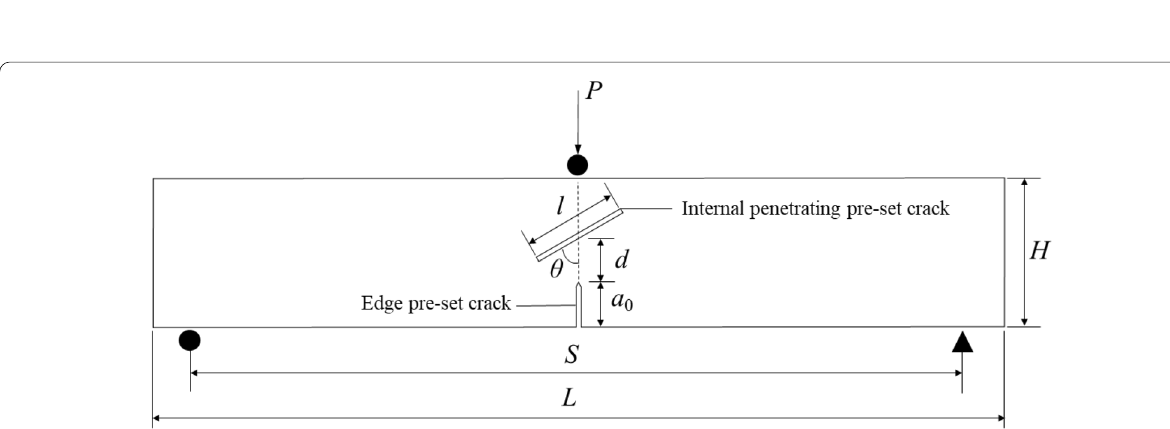
Fig. 5 Dimension diagram of three‑point bending